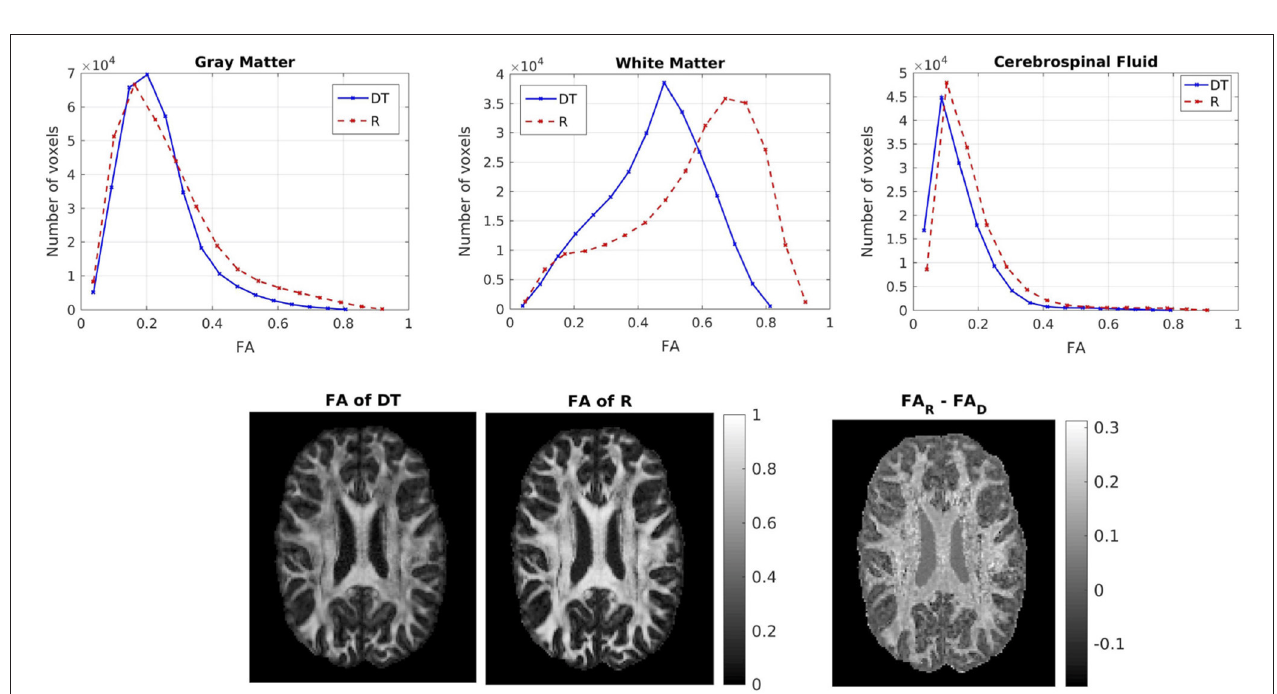
FIGURE 5 | (Top) Histogram of the FA of the two tensors in voxels identified as GM (left), WM (center), and CSF (right). The solid lines represent D w and the dashed lines represent R w . (Bottom) FA of D w (left), FA of R w (center), difference of the FAs (right) for axial slice 70. The FAs of the two tensors are plotted on the same scale.